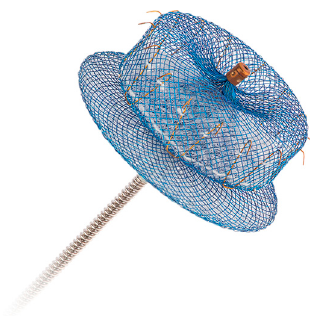
Figure 2. The Amplatzer Amulet device (reproduced with permission from Abbott).